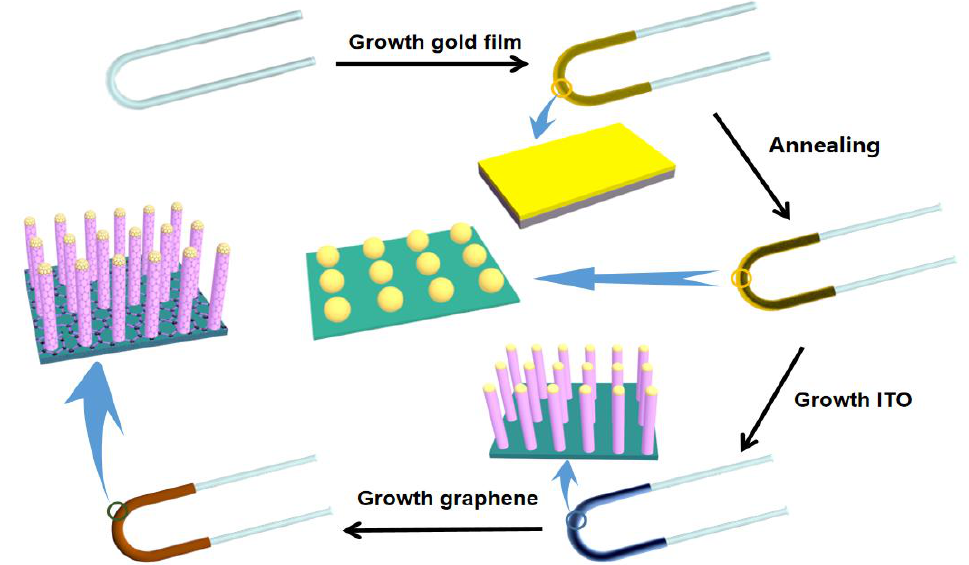
Figure 1. The schematic representation of the preparation procedure of Gr/ITO-NM/U-bent-A sensor.